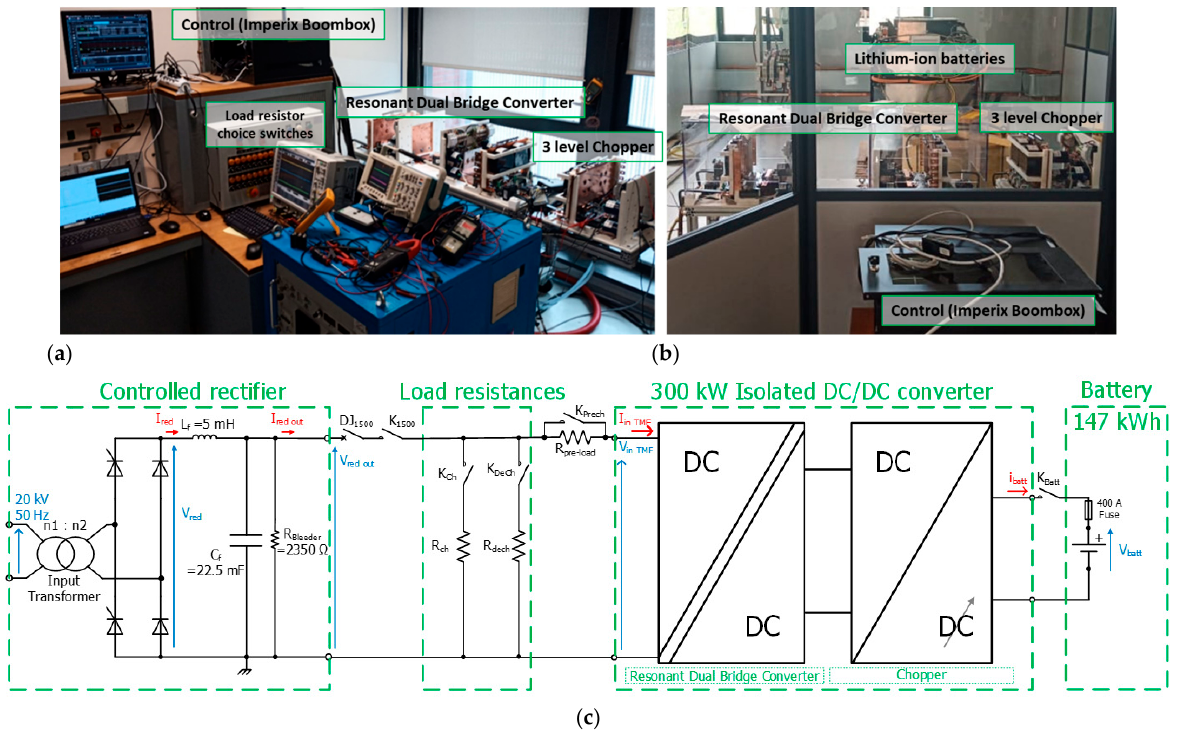
Figure 15. Prototype of the 300 kW/147 kWh elementary block: ( a ) picture of the isolated DC/DC converter in the LAPLACE laboratory test platform (resistive load test); ( b ) picture of the isolated DC/DC converter in the SCLE-SFE test platform; and ( c ) electrical diagram of converter under test.